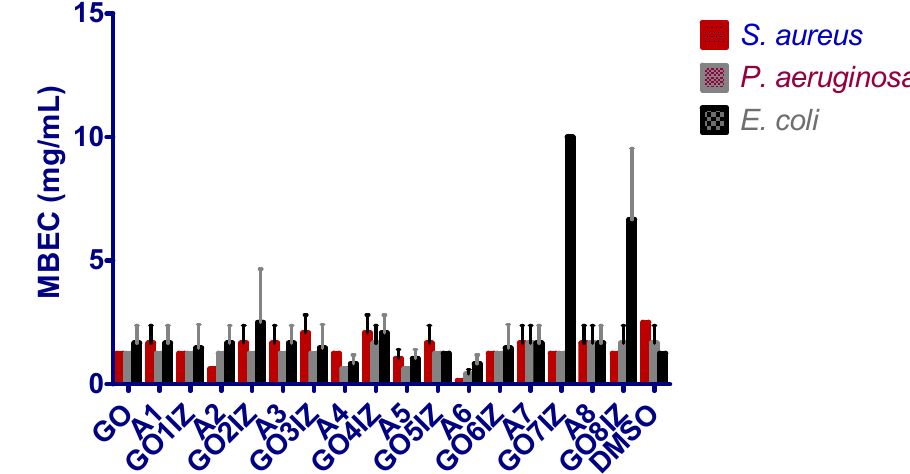
Figure 7. MBEC values obtained for the synthesized compounds against the tested strains.